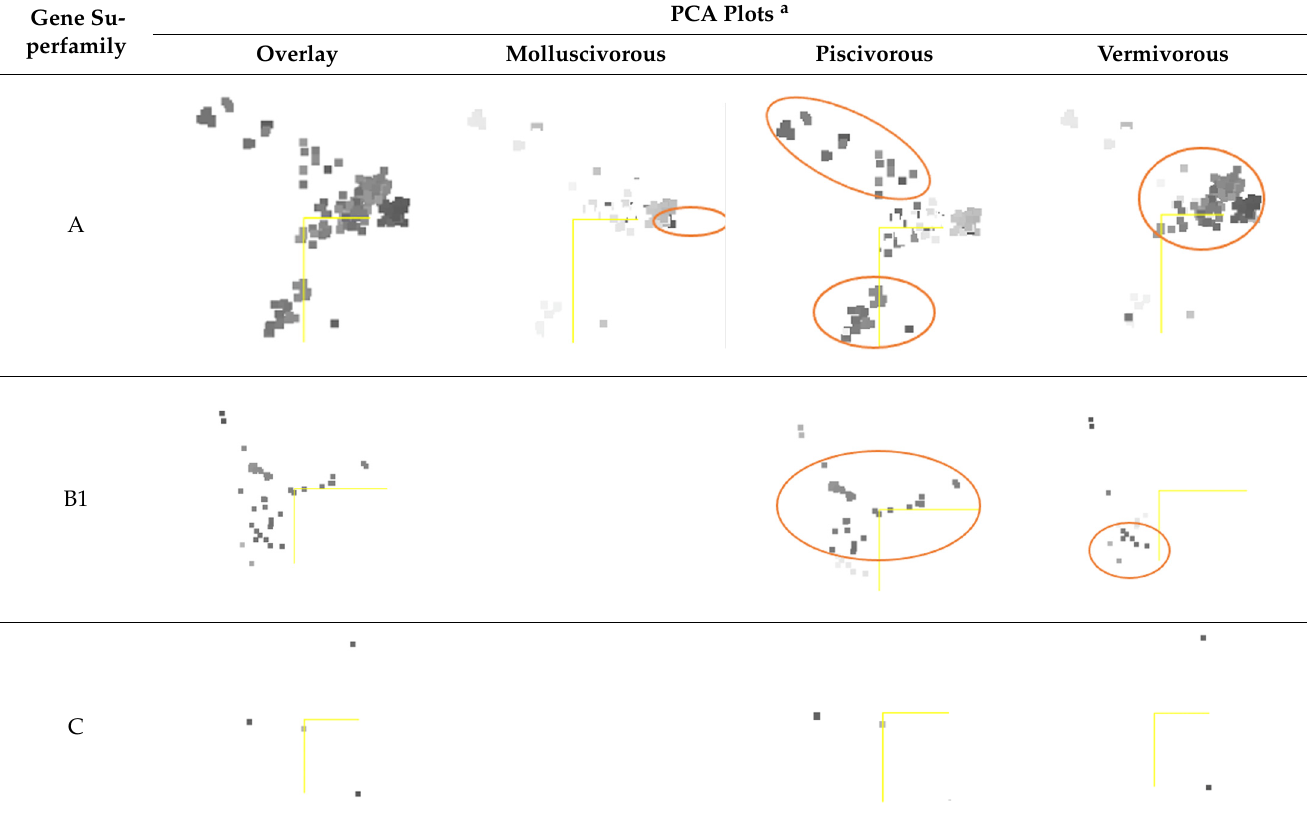
Table 2. Principal component analysis plots.